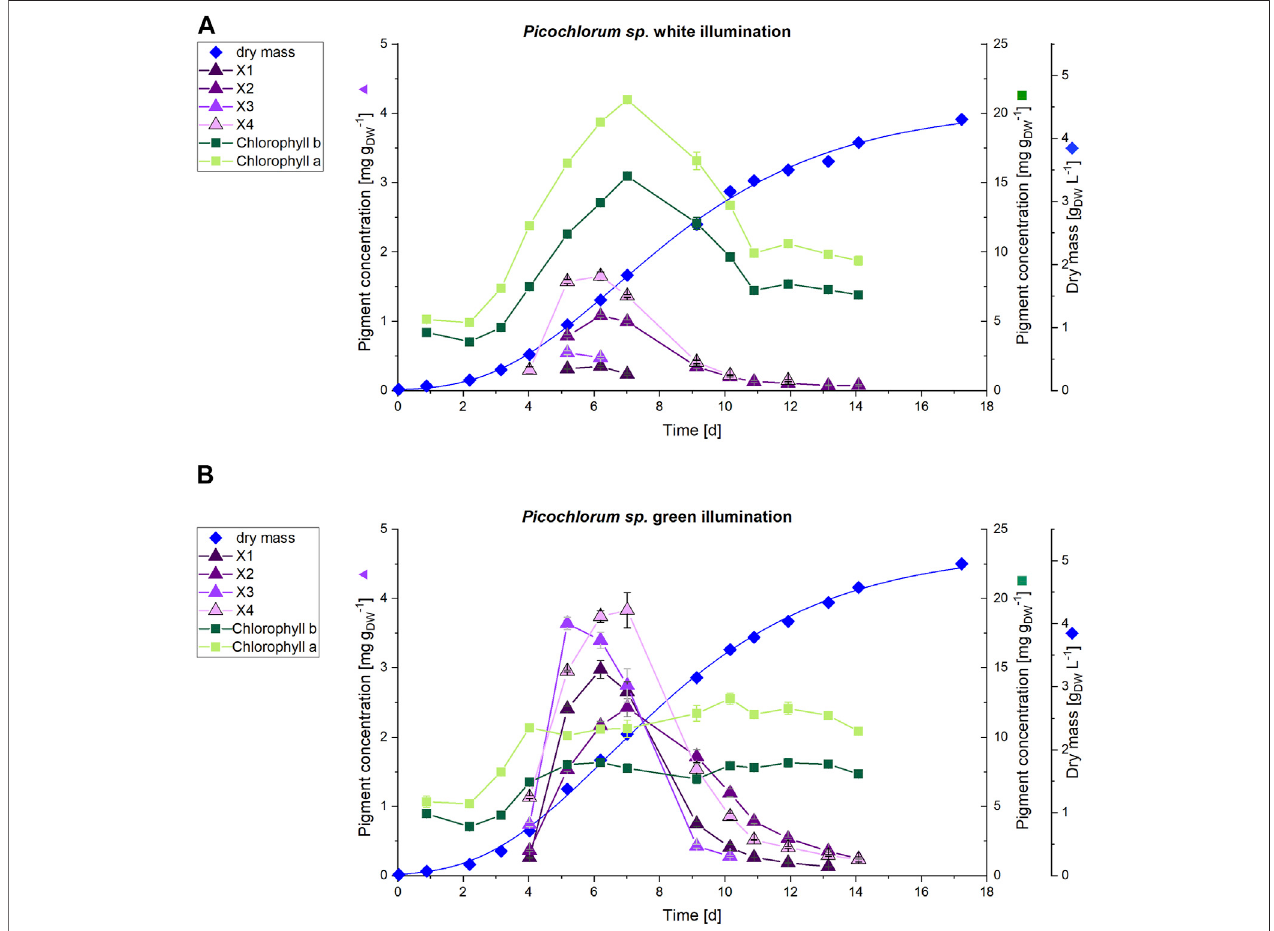
FIGURE 6 | HPLC analysis of pigments (n = 3) of (A) white and (B) green illuminated Picochlorum sp. cultures at 150 μ mol m − 2 s − 1 . The scale for dry mass values (diamonds) is shown on the far right, while that for the concentrations of unknown pigments X1-4 (triangles) is on left side axis. Concentrations of chlorophyll a and b (squares) on the right side